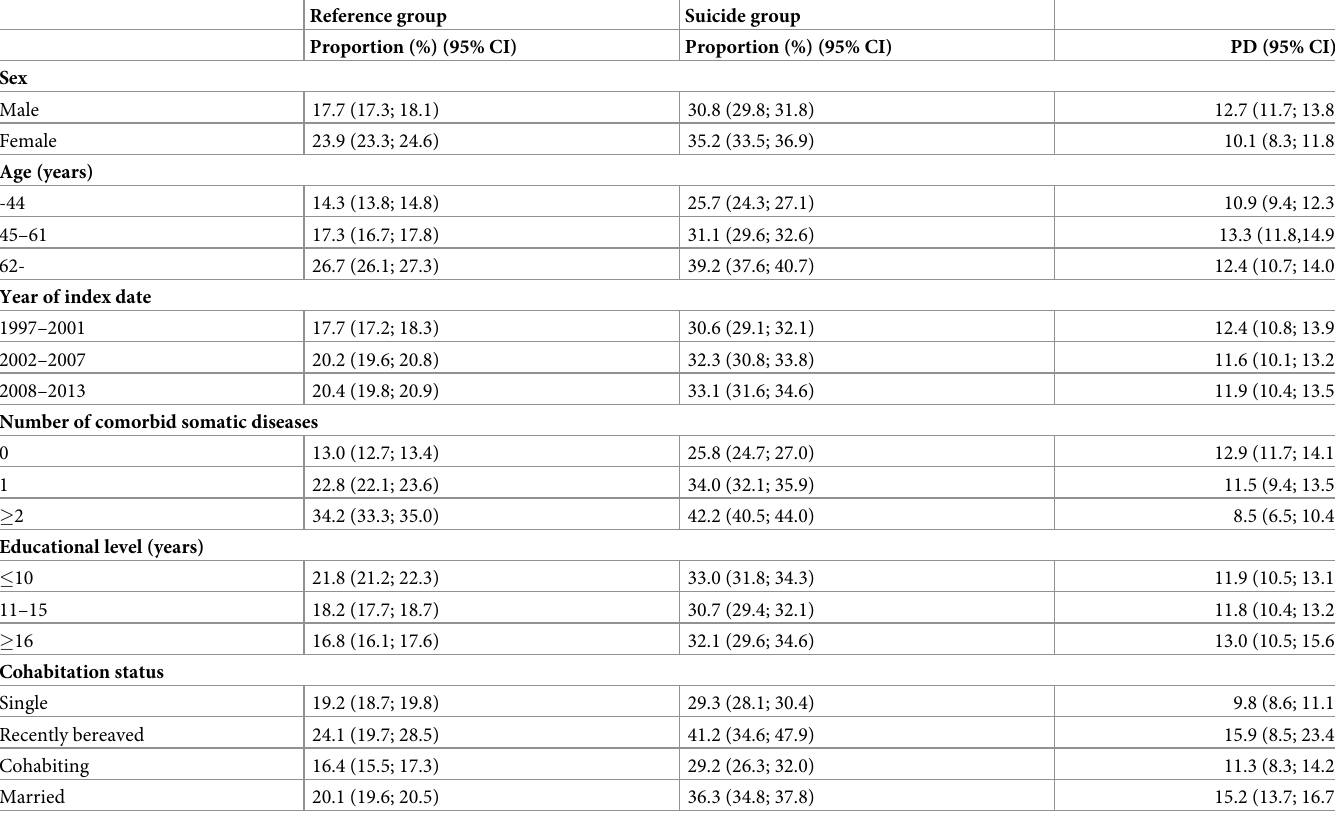
Table 3. Proportion and proportion difference (PD) for daytime face-to-face contacts in the month before index date in subgroups. Reference